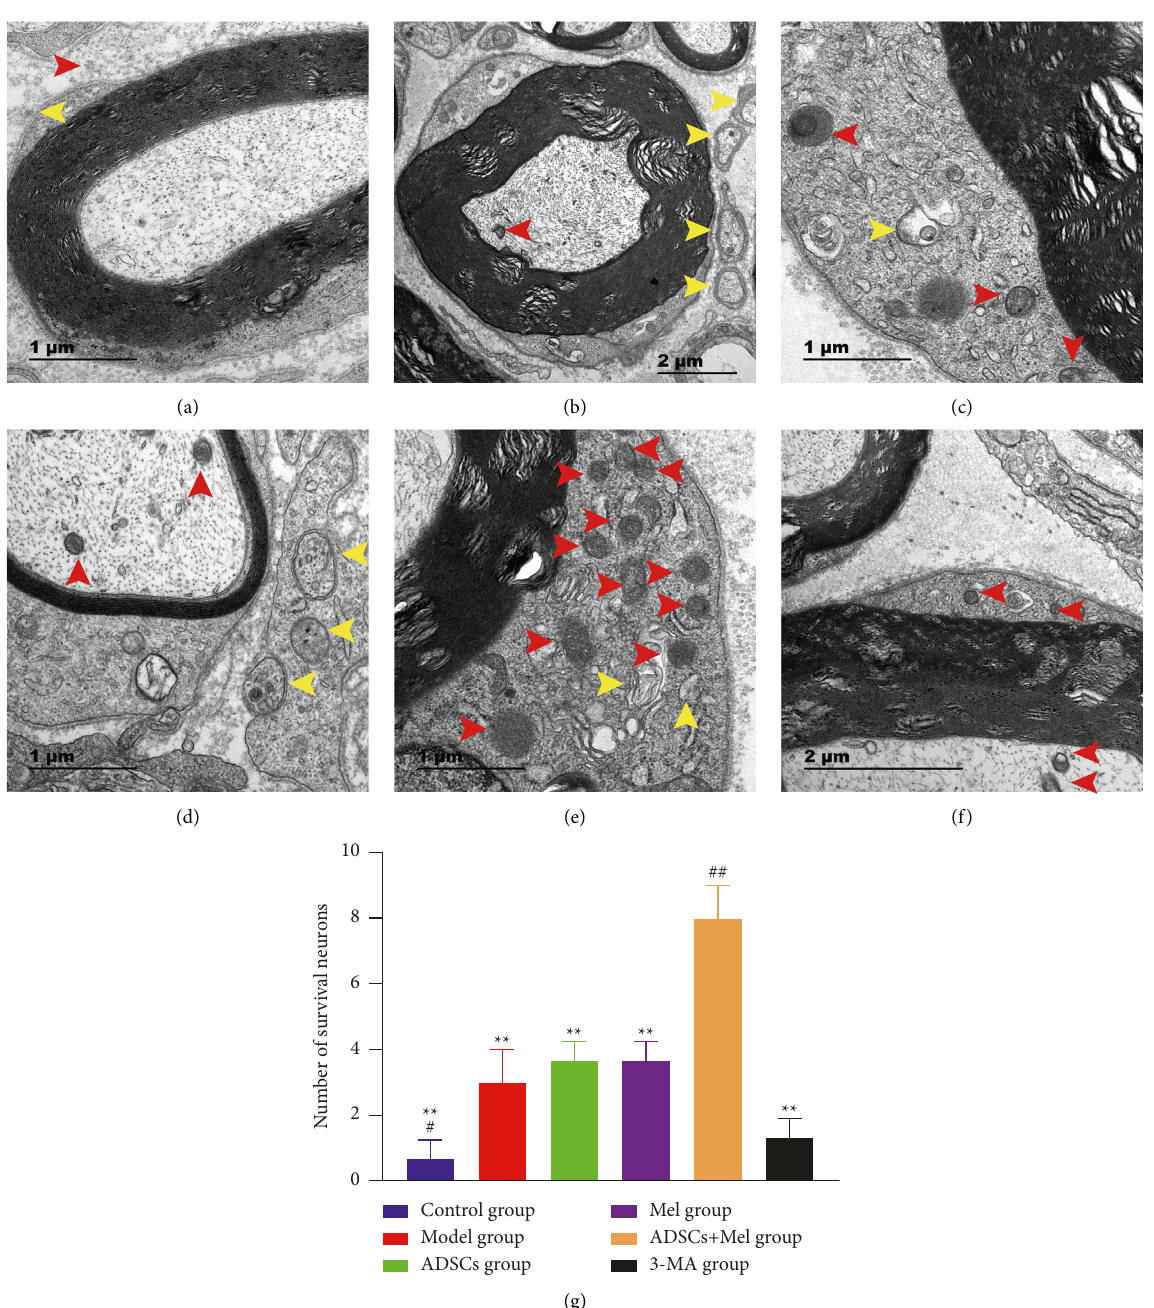
Figure 7: The mutations of autophagosomes on the 7th day after the sciatic nerve injury in rats were observed by electron microscopy. (a) Control group. (b) Model group. (c) ADSCs group. (d) Mel group. (e) Mel + ADSCs group. (f) 3-MA group. There are auto- phagosomes (yellow arrows) and lysosomes (red arrows) in the sciatic nerve. (g) Number of autophagosome statistics. The control group, ADSCs group, Mel group, ADSCs + Mel group, and 3-MA group were compared with the model group, respectively. Each value is the mean ± SE of four independent determinations. ## P < 0 . 01 and # p < 0 . 05 compared with the model group; ∗∗ p < 0 . 05, the control group, ADSCs group, model group, Mel group, ADSCs + Mel group, and 3-MA group were compared with the ADSCs + Mel